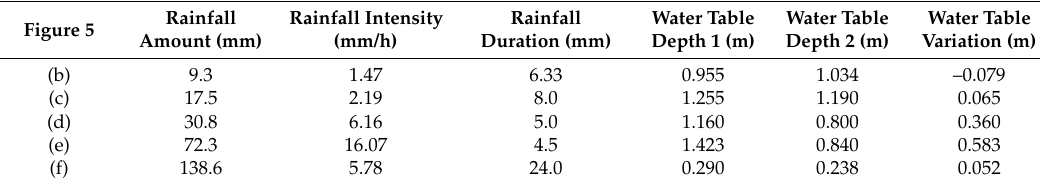
Table 2. Variation of shallow groundwater table under different rainfall conditions. Rainfall Rainfall Intensity Rainfall Amount (mm) (mm/h) Duration